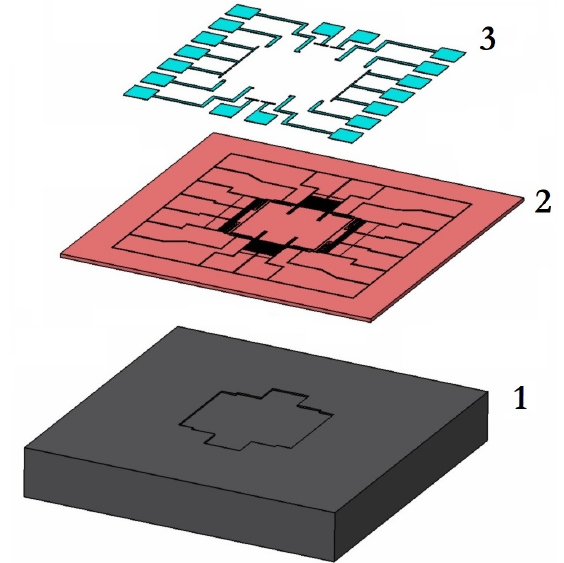
Figure 26. Layered structure of the SE of the MEMS gyroscope. ( 1 ) a glass base with a recess for movable structures; ( 2 ) a bottom layer with the developed topology of the SE; ( 3 ) a metallization layer for soldering a thin wire into the